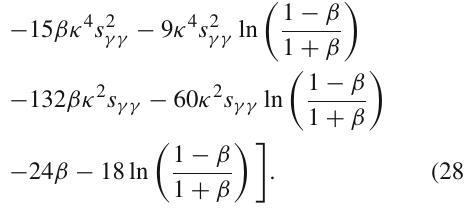
Fig. 9 Angular distributions for monopole-antimonopole pair produc- for various values of the parameter ˜ κ . The case ˜ κ = 0 is analogous to tion via PF for the case of a fermionic monopole with spin 1 / 2 and the SM expectation and is clearly distinctive as the only unitary and mass M = 1 . 5 TeV as a function of the scattering angle θ (left) and renormalisable √ s γγ = 2 E γ , where E γ = 6 M , and the pseudorapidity η (right) at